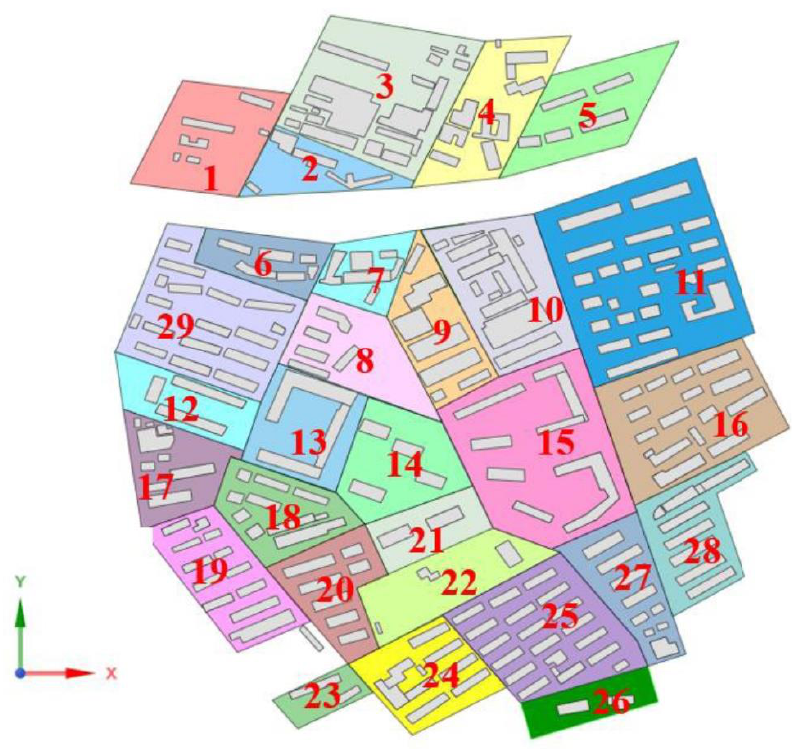
Figure 16. The region is divided according to the city texture.